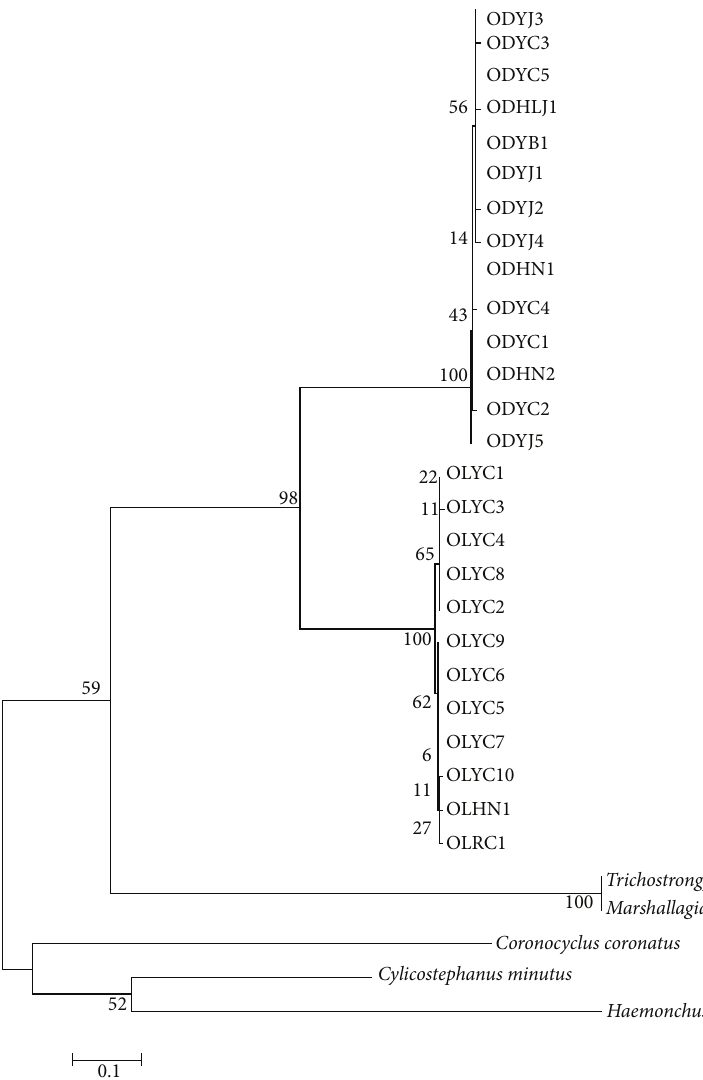
Figure 2: Phylogenetic relationships of Oesophagostomum and O. quadrispinulatum isolates inferred by neighbor-joining (NJ) method with model of Kimura 2-parameter based on sequences of intergenic spacer rDNA (IGS rDNA). Bootstrap values (in %) above 50% from 1000 pseudoreplicates are shown for the NJ analyses. Scale bar indicates an evolutionary distance of Kimura 2-parameter